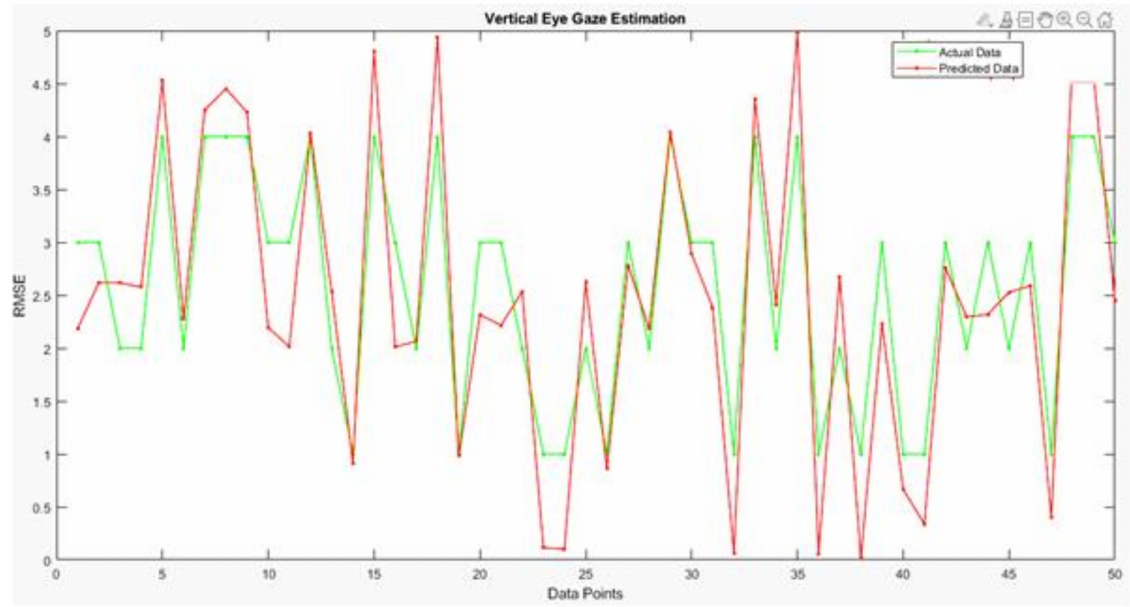
Figure 17. Analysis of the proposed vertical eye gaze estimation model using the line